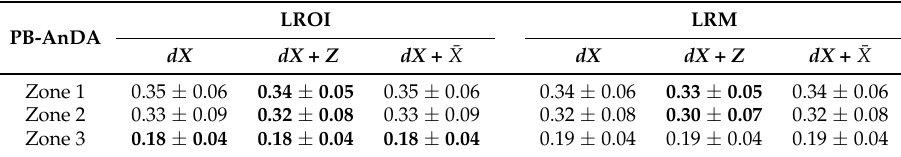
Table 1. Interpolation performance of PB-AnDA models for the MW SST case-study for three zones of interest in the case-study region: we refer the reader to the main text for the description of the different PB-AnDA